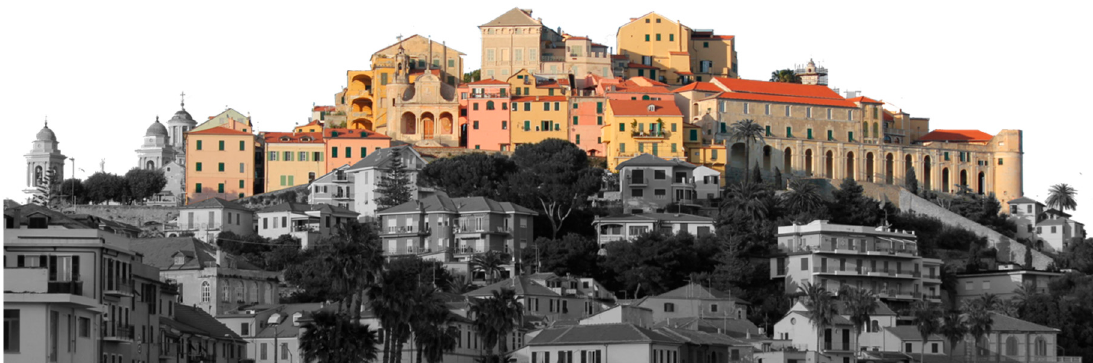
Figure 2. Image of the Parasio district.